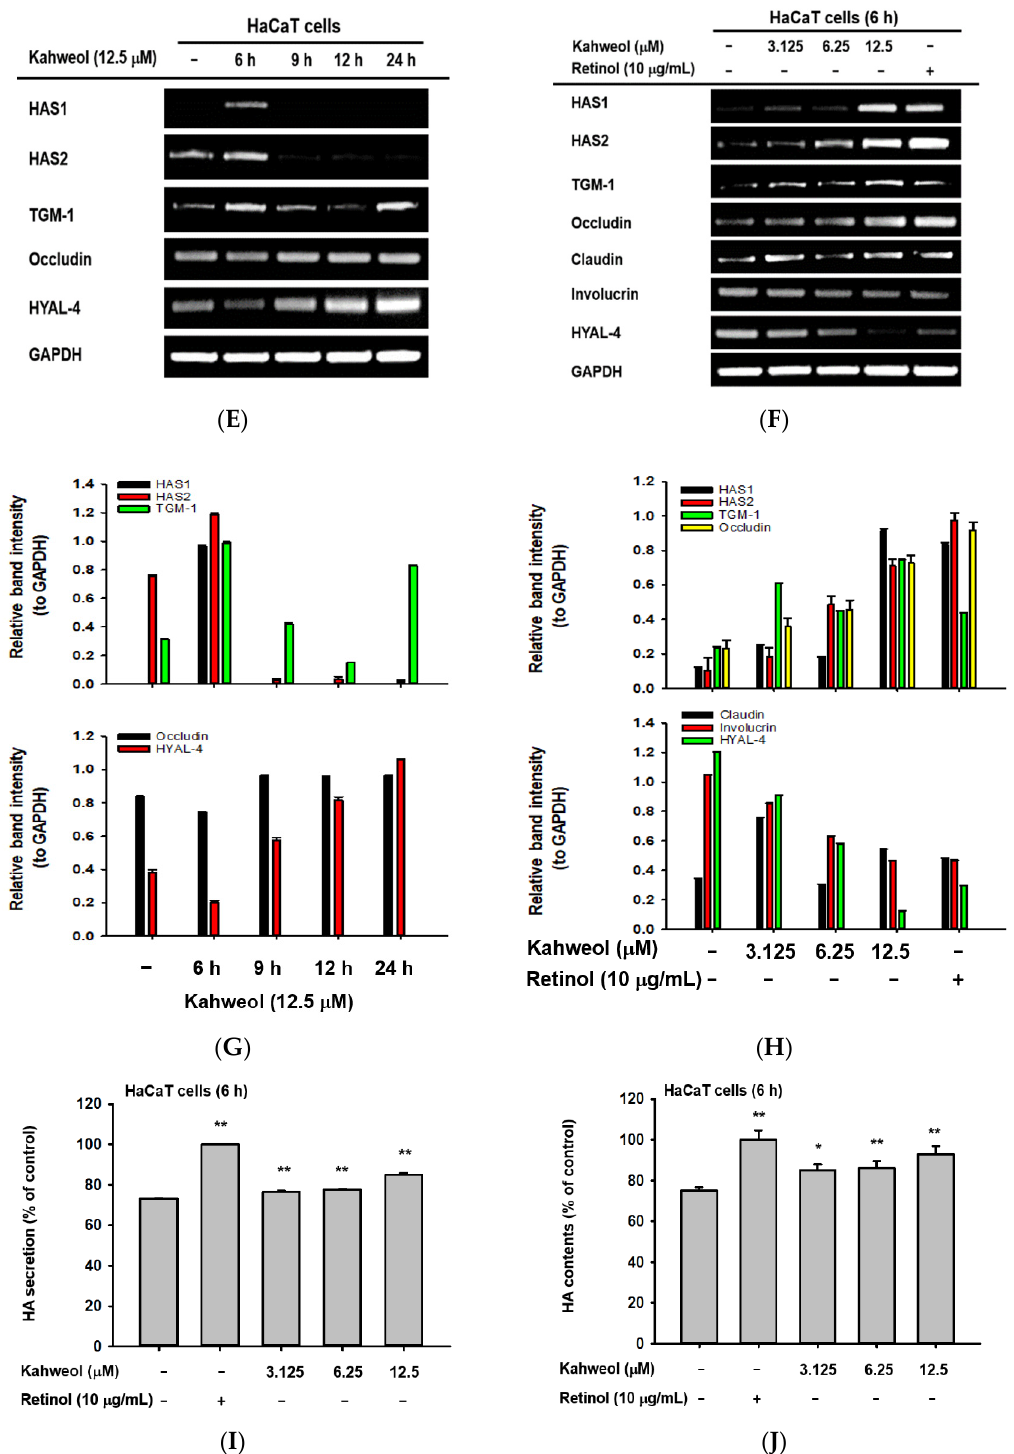
Figure 2. Skin-protective effects of kahweol. ( A ) Schematic design of this study. ( B ) Viability of HaCaT cells and HEK293T cells treated with different concentrations of kahweol was evaluated by MTT assay. ( C , D ) The radical-scavenging effects of kahweol (12.5, 25, 50, 100, and 200 μ M) and AA (500 μ M) were assessed by ( C ) DPPH assay and ( D ) ABTS assay. ( E , F ) After treatment of kahweol with indicated concentrations, HaCaT cells were collected at different time points. Then, the expression levels of HAS1 , HAS2 , TGM-1 , occludin , claudin , involucrin and HYAL-4 were measured by RT-PCR. ( G , H ) The relative intensities of mRNA levels of HAS1 , HAS2 , TGM-1 , occludin , claudin , involucrin and HYAL-4 were measured by ImageJ. ( I , J ) After treatment with 12.5 µ M of kahweol for 6 h in HaCaT cells, the ( I ) secretion and ( J ) contents of HA were measured by HA assay. * p < 0.05 and ** p < 0.01 compared to normal